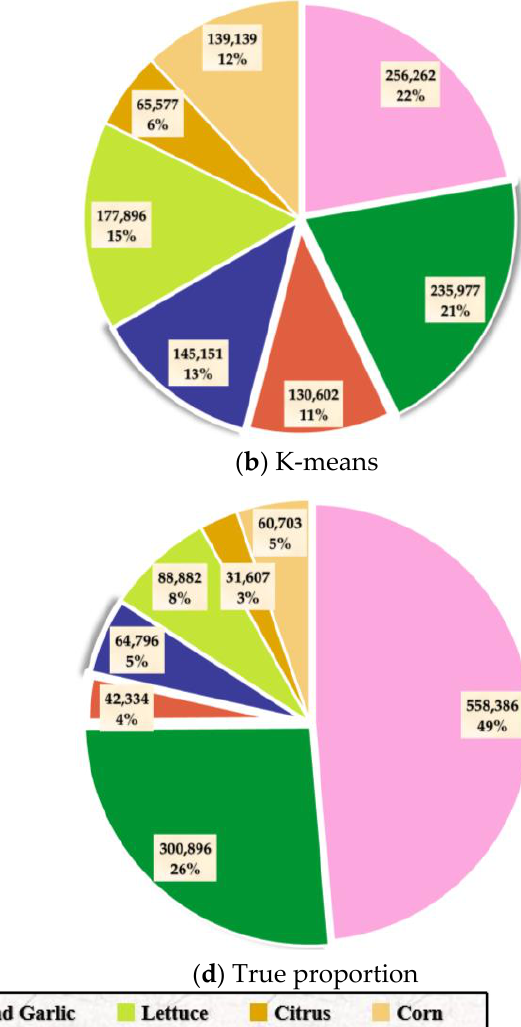
18 of 24 Figure 12. Clustering maps of the Imperial Dataset produced using different methods with random initial cluster centers. ( a ) FAISS; ( b ) K-means; ( c ) DTIC; ( d ) reference map. Table 6 displays the clustering performance of different methods when the averaged initial cluster centers are specified. The three criteria are also applied to performance eval- uation. It can be concluded that DTIC outperforms the other methods by 56.7%, 57,7%, and 73.9% relative to the second-best results on each criterion, respectively. We observe that even if the initial clustering center is specified, other methods do not produce an ac- ceptable result. This phenomenon shows that other methods have failed to cluster the large-scale and imbalanced dataset under any initial cluster center conditions. Neverthe- less, DTIC has the best performance compared to the Reunion Island Dataset. We consider the qualities of original features and PCA to play an important role in the generated re- sults. Table 6. A comparison of different methods on the Imperial Dataset with averaged initial cluster centers. The bolded results show the best results. Algorithms Metrics